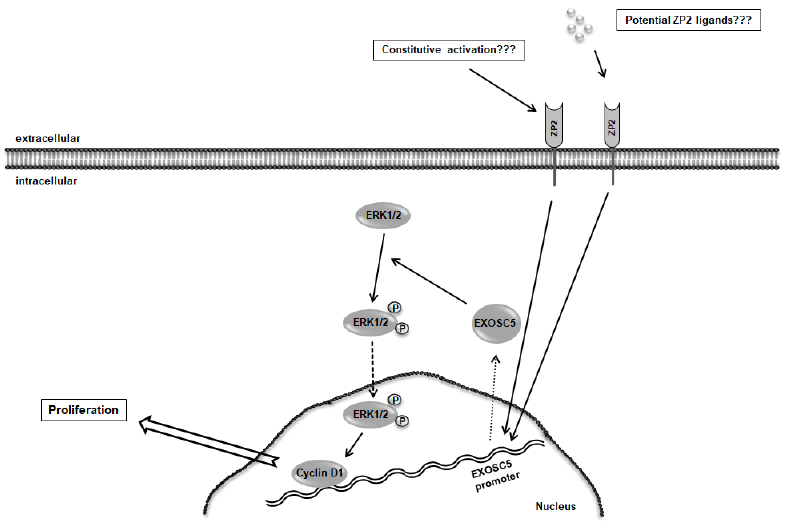
Figure 7. Schematic summary shows the proposed function of ZP2 in participating in colon cancer cell proliferation. It is speculated that ZP2 might act as a membrane-bound receptor-like protein, which could positively affect EXOSC5 expression, leading to ERK1/2 activation and thus up-regulation of cyclin D1, hence showing a potential impact on cell proliferation. Black arrows represent activating processes, the dashed arrow shows exclusive transport, the dotted arrow shows increased biosynthesis as well as transport, while the block arrow exhibits a cellular process (proliferation).